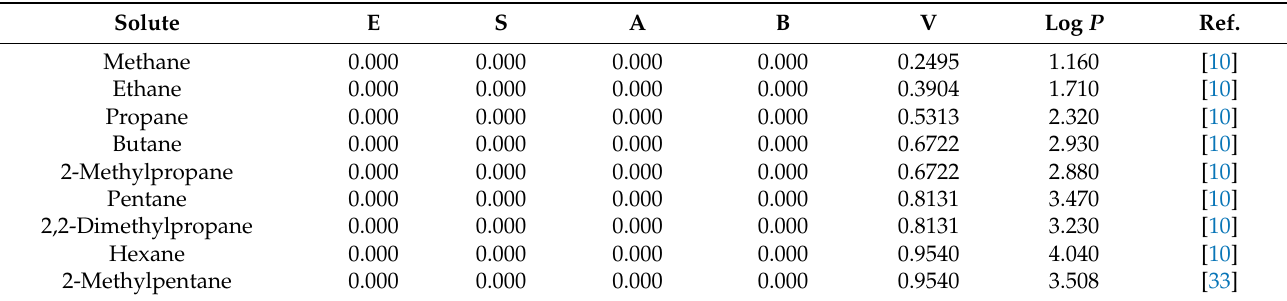
Table 1. Experimental water-to-polydimethylsiloxane partition coefficient, log P PDMS-water (wet + dry), measured near 298 K, along with the Abraham model solute descriptors of compounds considered in the current